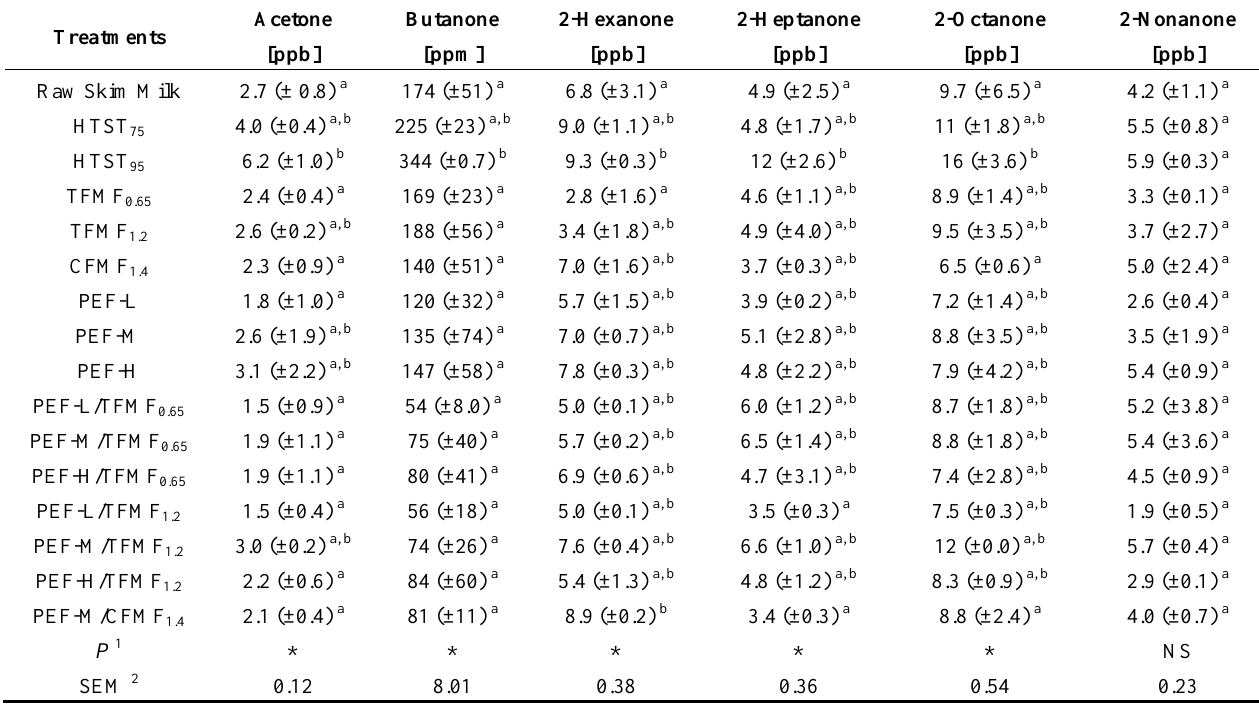
Table 4. Retention of in acetone, butanone, 2-hexanone, 2-heptanone, 2-octanone and 2-nonanone obtained in skim milk after high temperature short time pasteurization (HTST = 75 °C for 20 s; HTST = 95 °C for 45 s) and lab-scale tangential-flow 75 95 microfiltration (TFMF = 0.65 µm; TFMF = 1.2 µm), pilot scale cross-flow 0.65 1.2 microfiltration (CFMF = 1.4 µm), pulsed electric field at low (PEF-L: 28 kV/cm; 1.4 2805 µs), moderate (PEF-M: 40 kV/cm, 1122 µs), and high (PEF-H: 40 kV/cm, 1571